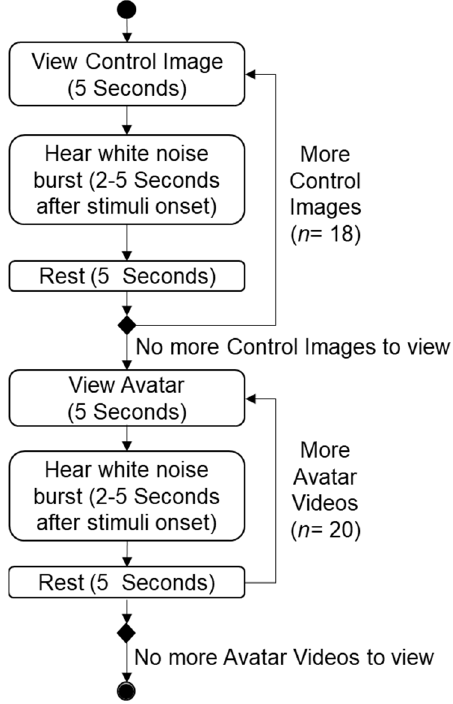
Figure 5. Data collection procedure